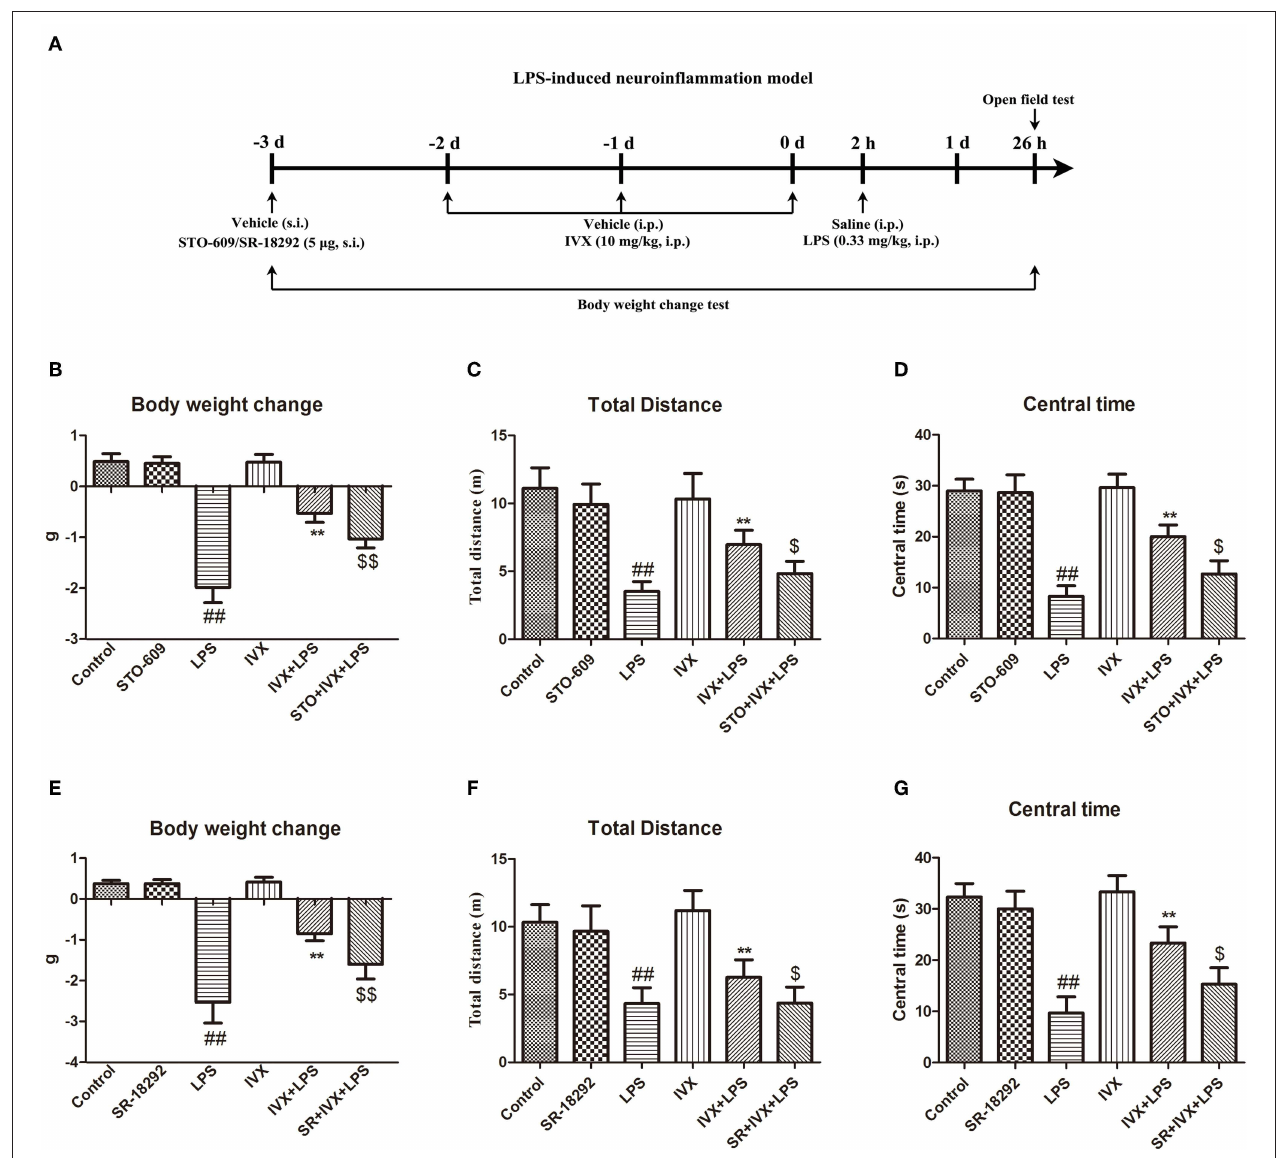
FIGURE 7 | IVX improved LPS-induced sickness behavior in mice. (A) Experimental design of a LPS-induced neuroinflammatory model. Mice were injected in the lateral ventricle with 5 µ g STO-609 or 5 µ g SR-18292 for 24h, then treated with intraperitoneally injected IVX (10 mg/kg) daily for 3 consecutive days and then subcutaneously injected with LPS (0.33 mg/kg) for 24h. (B,E) The changes in mouse body weight from before to after the experiment. (C,D,F,G) The locomotor activity of mice was measured via an open field test. Results are expressed as means ± SEM ( n = 8–10, in each group). ## p < 0.01, vs. control group; ** p < 0.01 vs. LPS group; $ p < 0.05 and $$ p < 0.01 vs. IVX + LPS group.